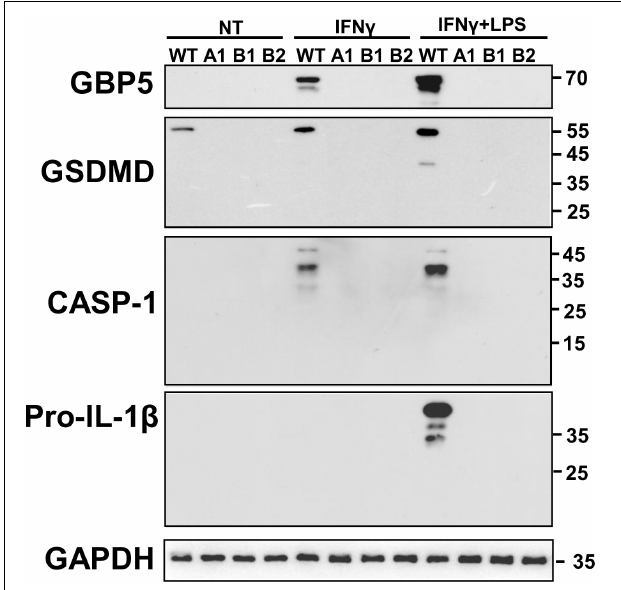
FIGURE 6 | Diminished expression of inflammasome related proteins in GBP5 knockout THP-1 cells was subjected to wild-type THP-1 cells, and GBP5 knockout THP-1 cell clones (A1, B1, and B2) were left untreated (NT), treated with IFN γ (25 ng/ml) only, or treated with IFN γ (25 ng/ml) plus LPS (500 ng/ml) for 16 h, before Western blot analysis with antibodies against GBP5, gasdermin D (GSDMD), caspase 1 (CASP1), pro-IL1 β , and GAPDH,